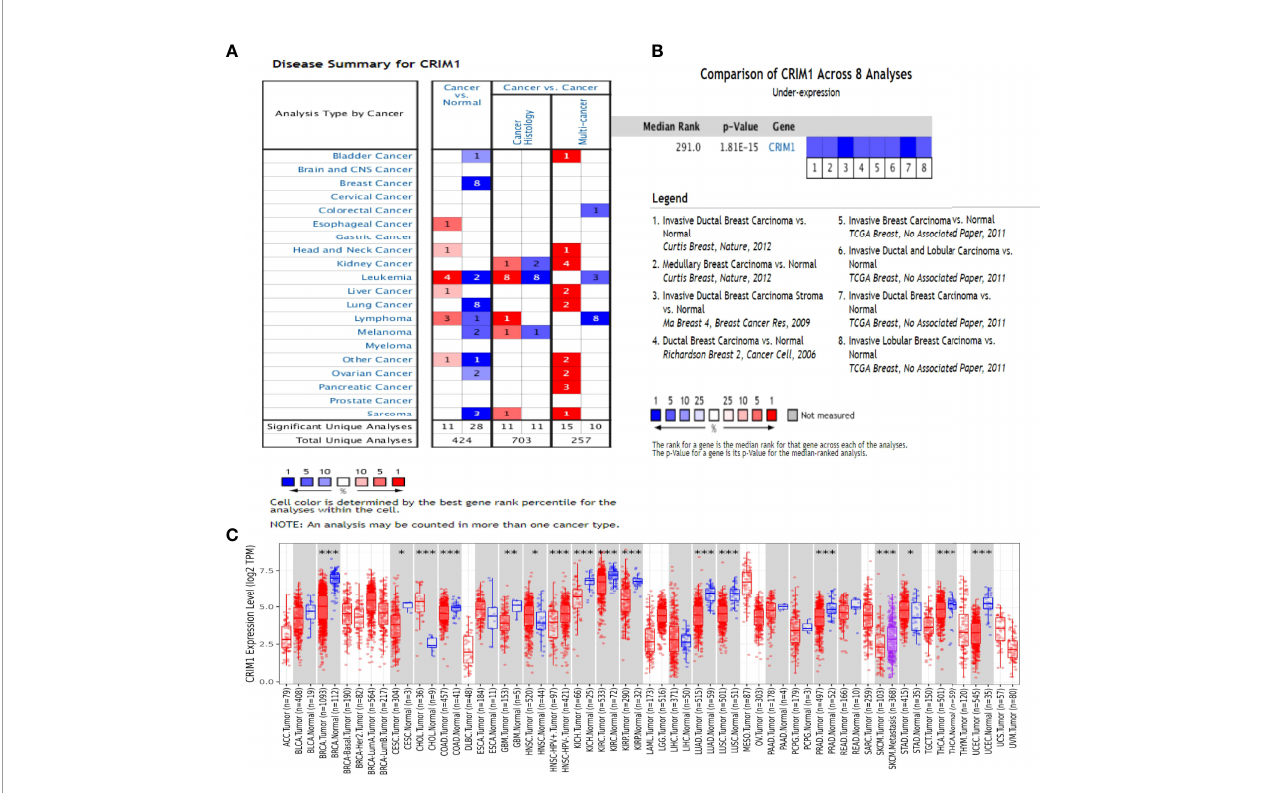
FIGURE 1 | The expression of CRIM1invarioushuman cancers(ONCOMINE data resource). (A) Increased ordecreased CRIM1levelsindifferent cancer datasets in contrast with non-malignant tissues. Red= upregulation, blue= downregulation.The lighter the color, the more meaningful itis. (B) Eight analyses show low levels of CRIM1 inbreast cancer. (C) Expression of CRIM1in distincttypes of human tumorsin the TIMER database. *p<0.05, **p<0.01,